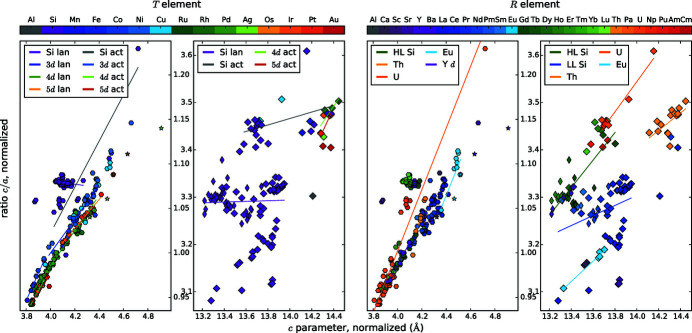
Correlations between c/a ratio and the lattice parameter c. The ratio c/a depends linearly on the c parameter of AlB2-like R
2
TSi3 compounds, with stronger influences from the R element (generally, large R means large c and large c/a).